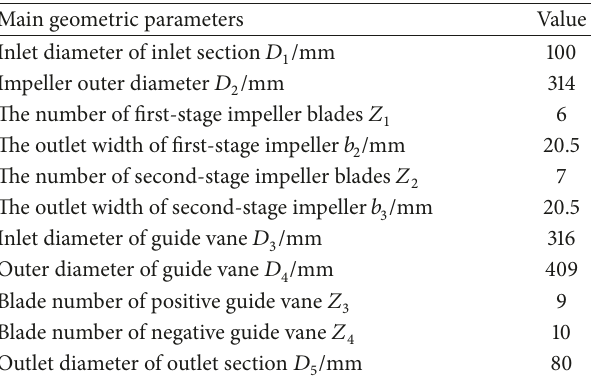
Table 1: Main structural